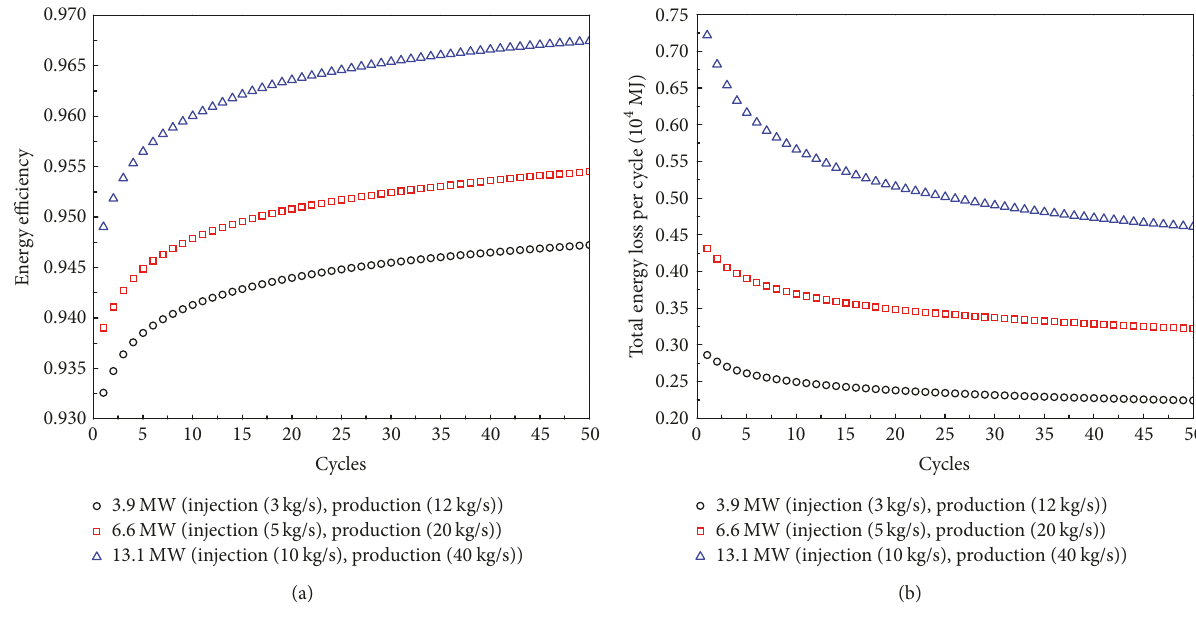
Figure 11: Comparison of the energy efficiencies and total energy losses during the 50 cycles under the three energy storage scales of a CAESA system. (a) Energy efficiency. (b) Total energy loss.